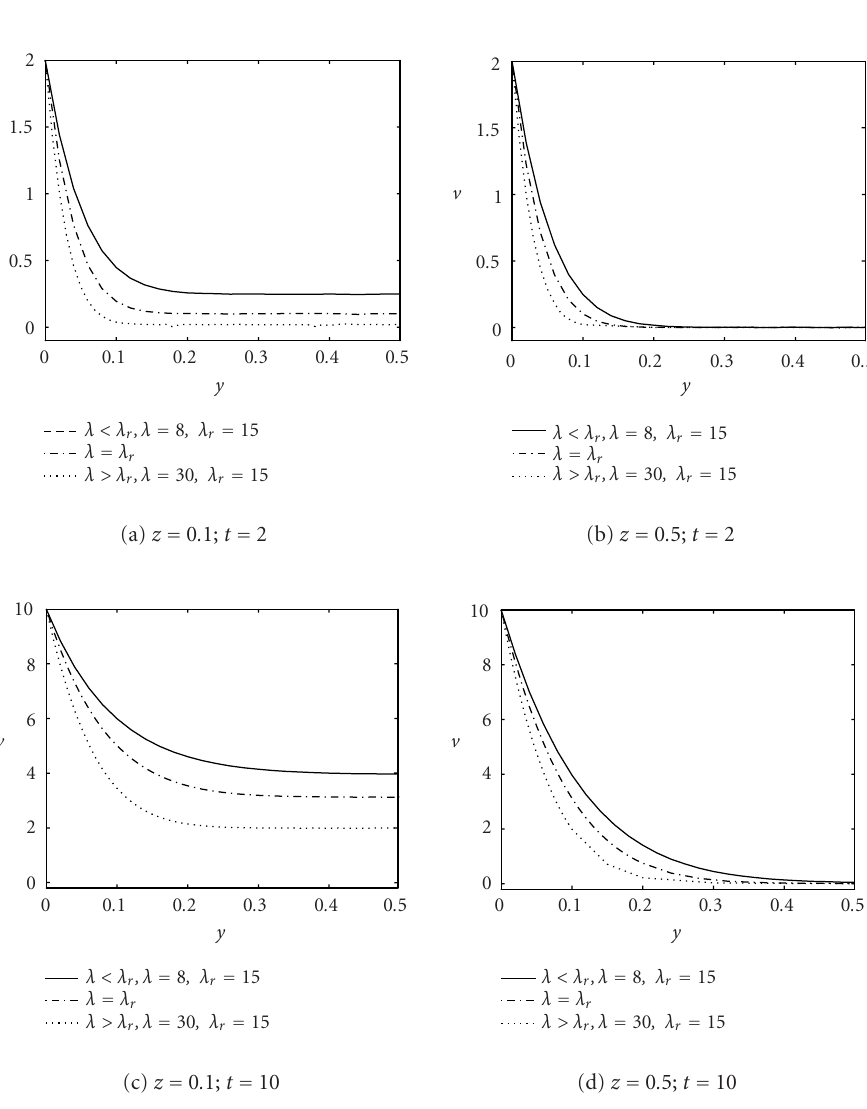
and second grade fluids, whose solutions (3.6), (3.9), (3.12), and (4.1), (4.2), and